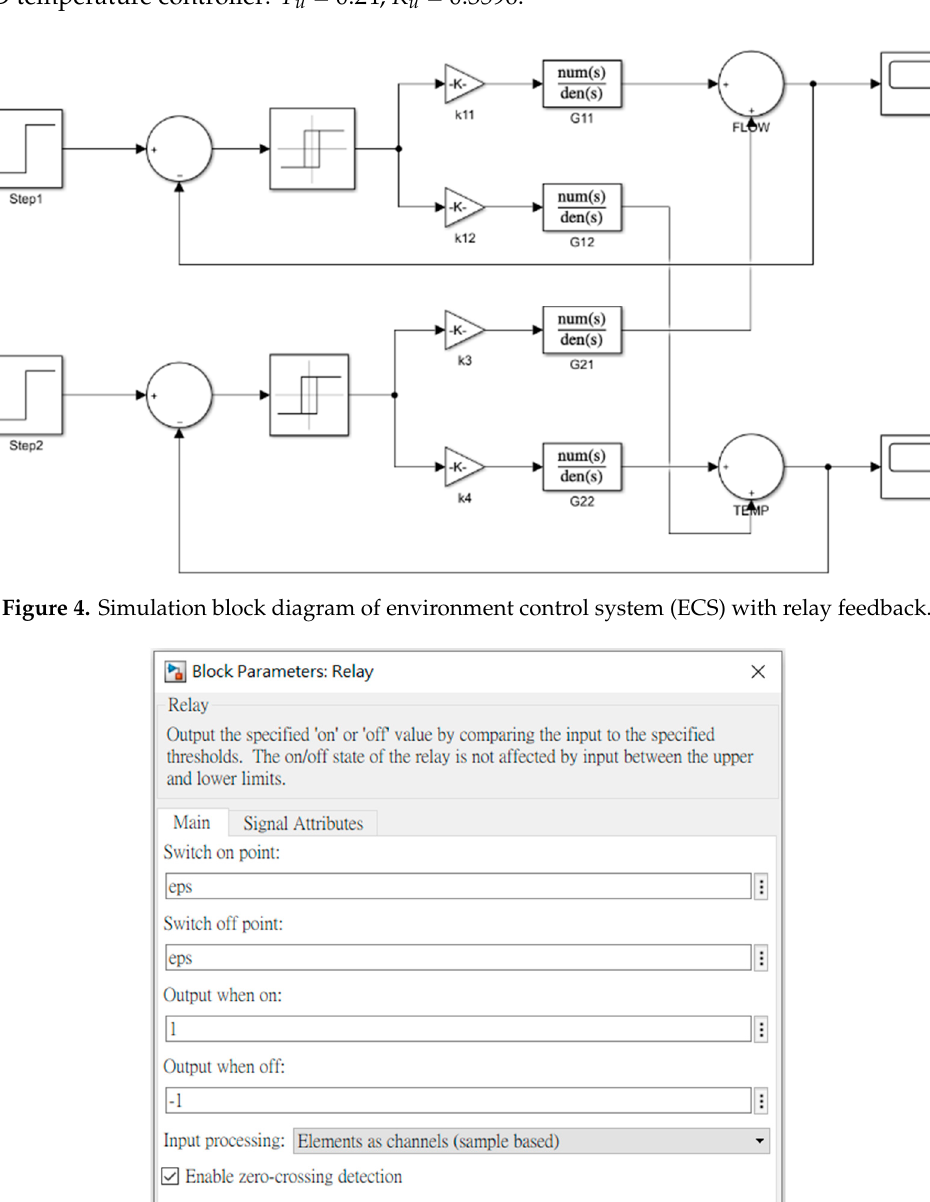
Table 1. Ziegler–Nichols test (Z–N) tuning method.